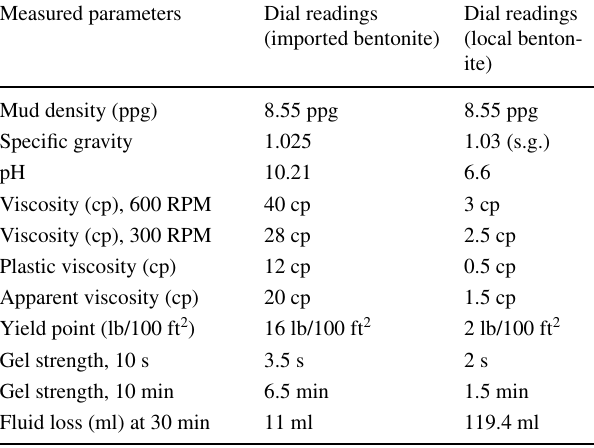
Table 2 Showing physiochemical properties of 20 g of imported and local Bentonites